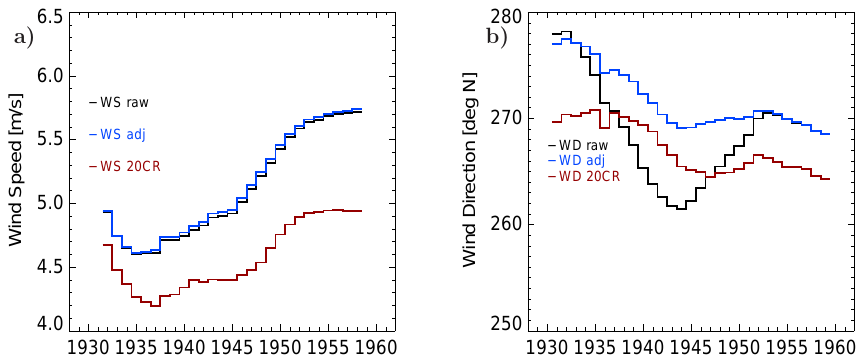
Figure 12. Unadjusted (raw), adjusted and NOAA-20CR wind speeds (a) and directions (b) in the period 1940–1960 at 700hPa, over a selected group of stations with long and complete time series (WMO numbers: 70261, 72206, 72208, 72250, 72261, 72293, 72317, 72363, Figure 12: Unadjusted (raw), adjusted and NOAA-20CR wind speeds (a) and directions 72365, 72405, 72469, 72493, 72518, 72528, 72562, 72572, 72597, 72632, 72681, 72698, 72764, 74626, 72231, 72334, 72374). Running (b) in the period 1940-1960 at 700hPa, over a selected group of stations with long and mean: 8 complete time series ( WMO numbers: 70261, 72206, 72208, 72250, 72261, 72293, 72317,